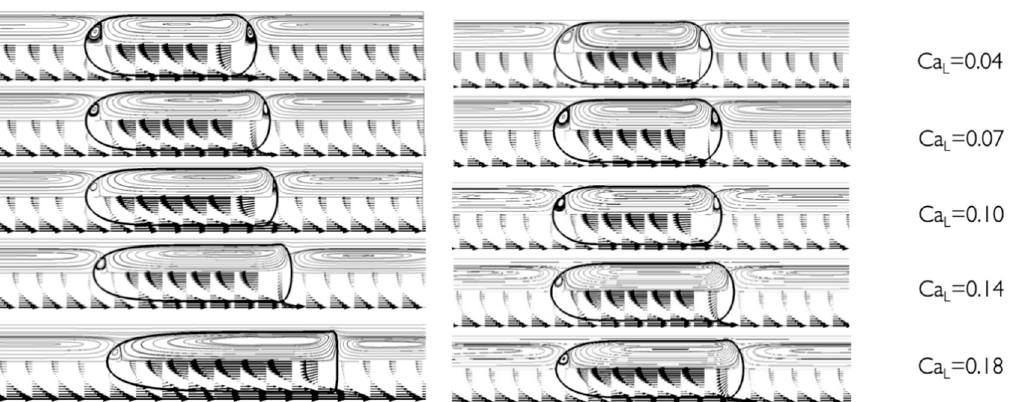
Figure 3. Numerical results of the velocity vectors and streamlines for systems with bubbles flowing through a 0.1% CMC solution (left) and a 0.5% CMC solution (right). The domain under consideration has a D = 100 μ m.